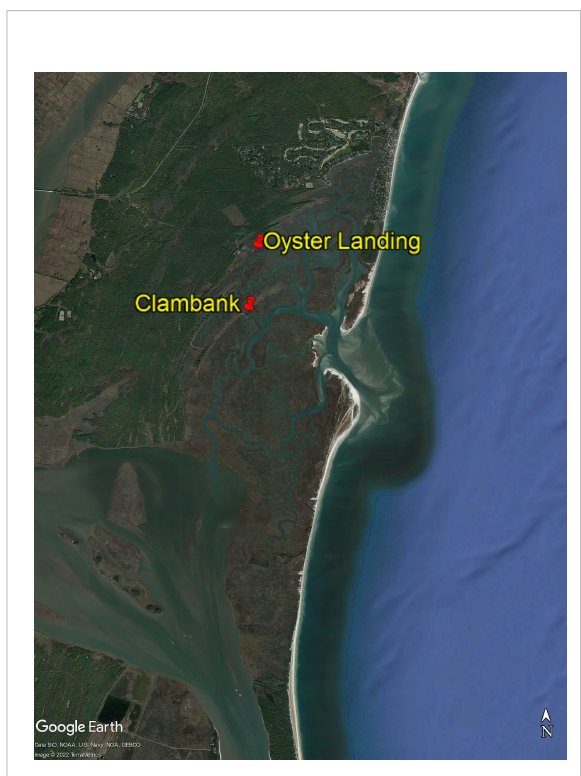
FIGURE 1 Samling locations (marked by pins) for salt marsh sediments at the North Inlet-Winyah Bay National Estuarine Research Reserve (33.35°N, 79.20°W). The image is produced using Google Earth Pro with data from SIO, NOAA, U.S. Navy, NGA, and GEBCO